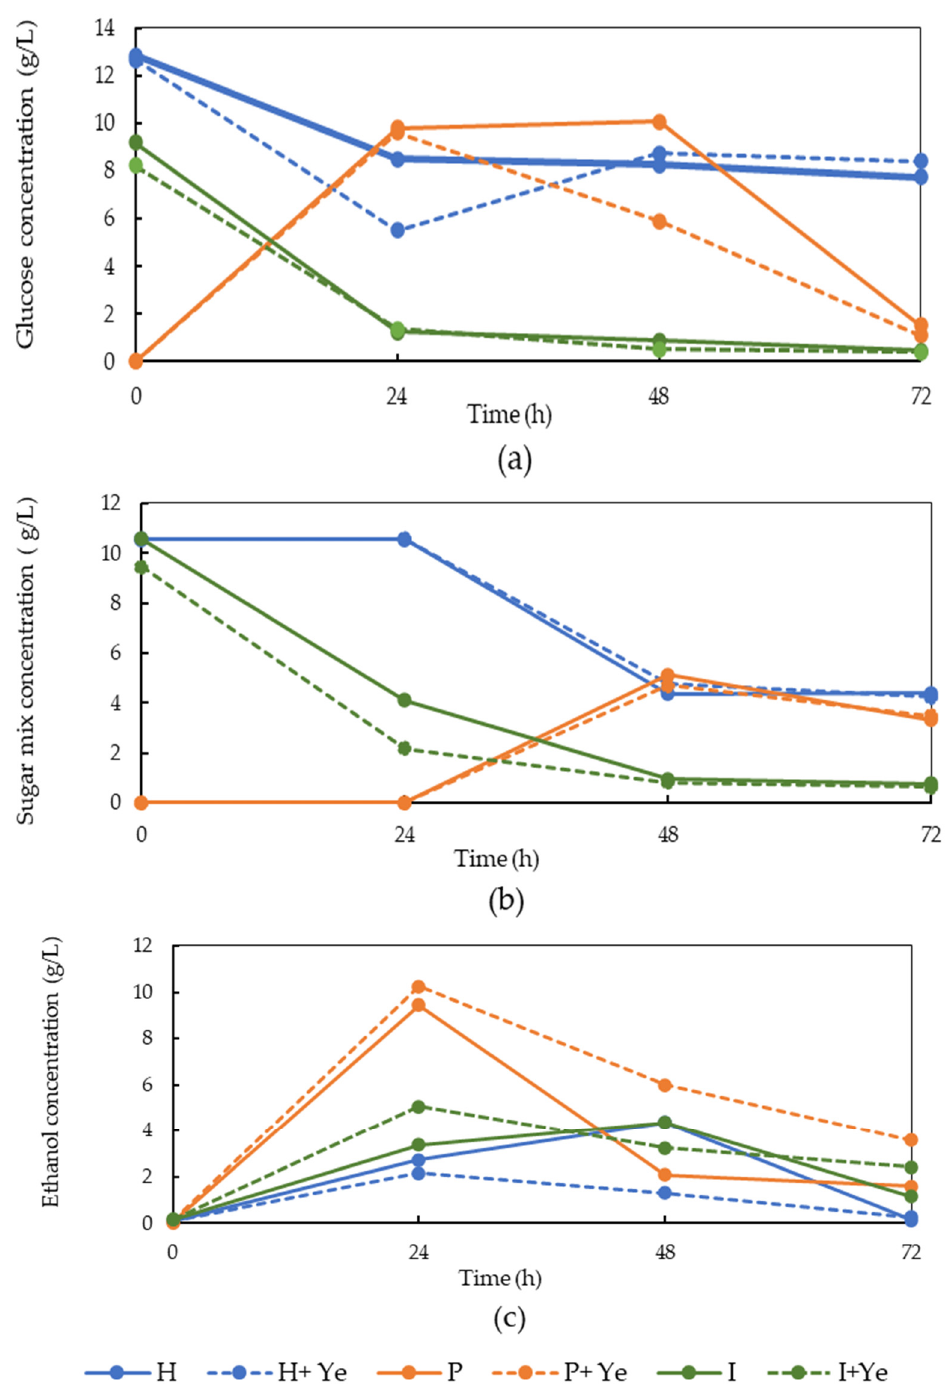
Figure 2. Glucose, sugar mix, and ethanol concentration profiles during fungal cultivation on LFCP obtained after the hemicellulase (H), pectinase (P), and invertase (I) pretreatments in the absence and presence of the yeast extract (Ye) in a 4.5 L bench-scale bubble column bioreactor during 72 h. ( a ) Glucose concentration ( b ) ethanol concentration, and ( c ) sugar mix concentration. The standard deviations were 0.01–2.3%.